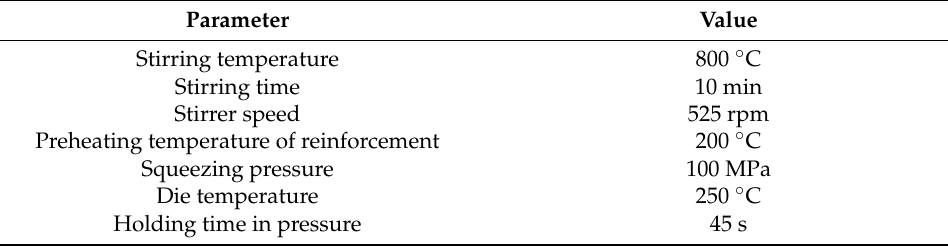
Figure 1. Schematic arrangement of squeeze casting setup. Table 3. Stir cum squeeze casting